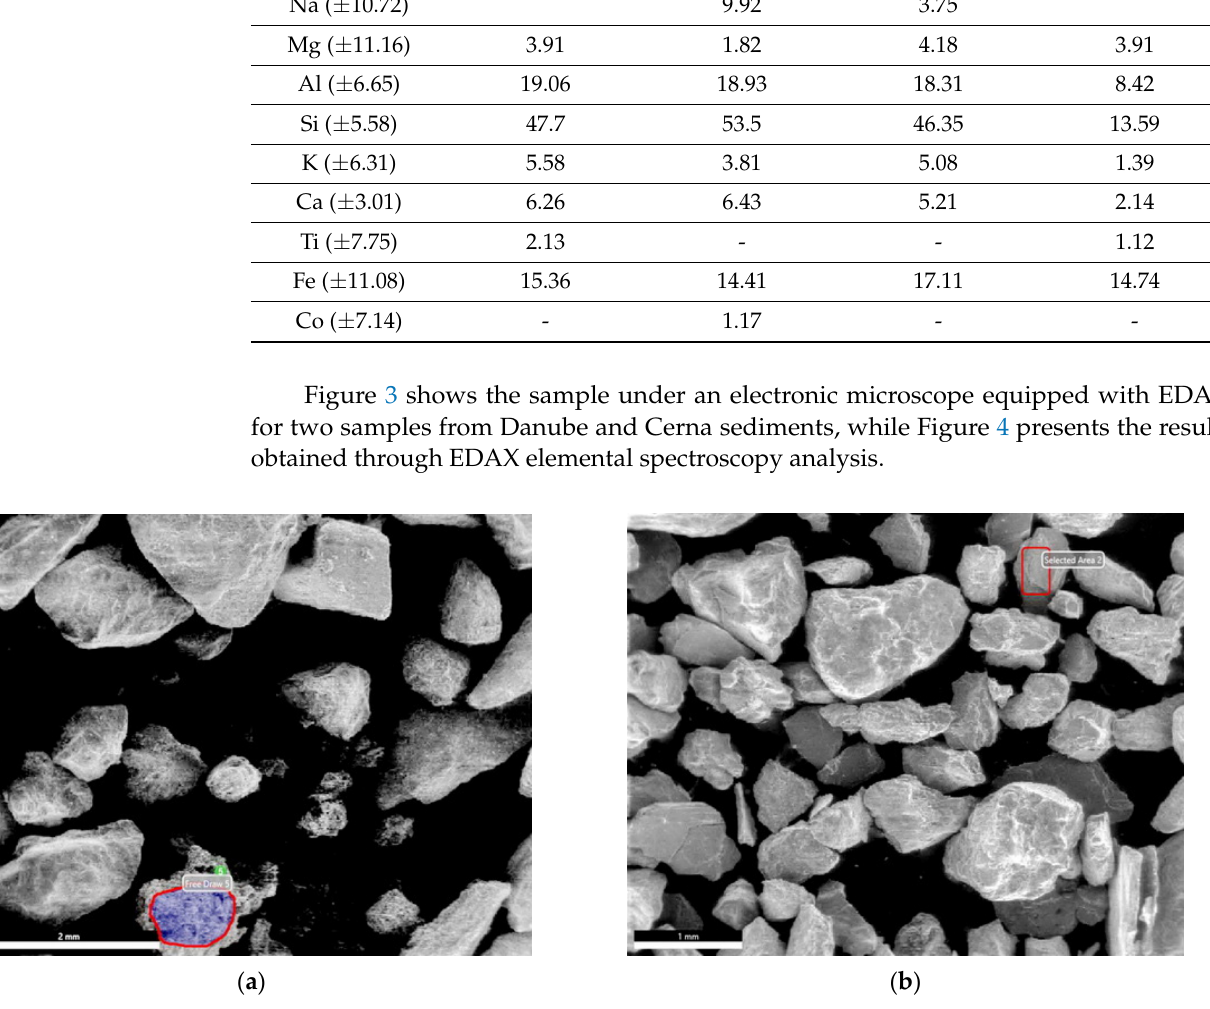
Figure 3. Sediment samples under electronic microscope: ( a ) example of Danube sample; ( b ) example of Cerna sample.